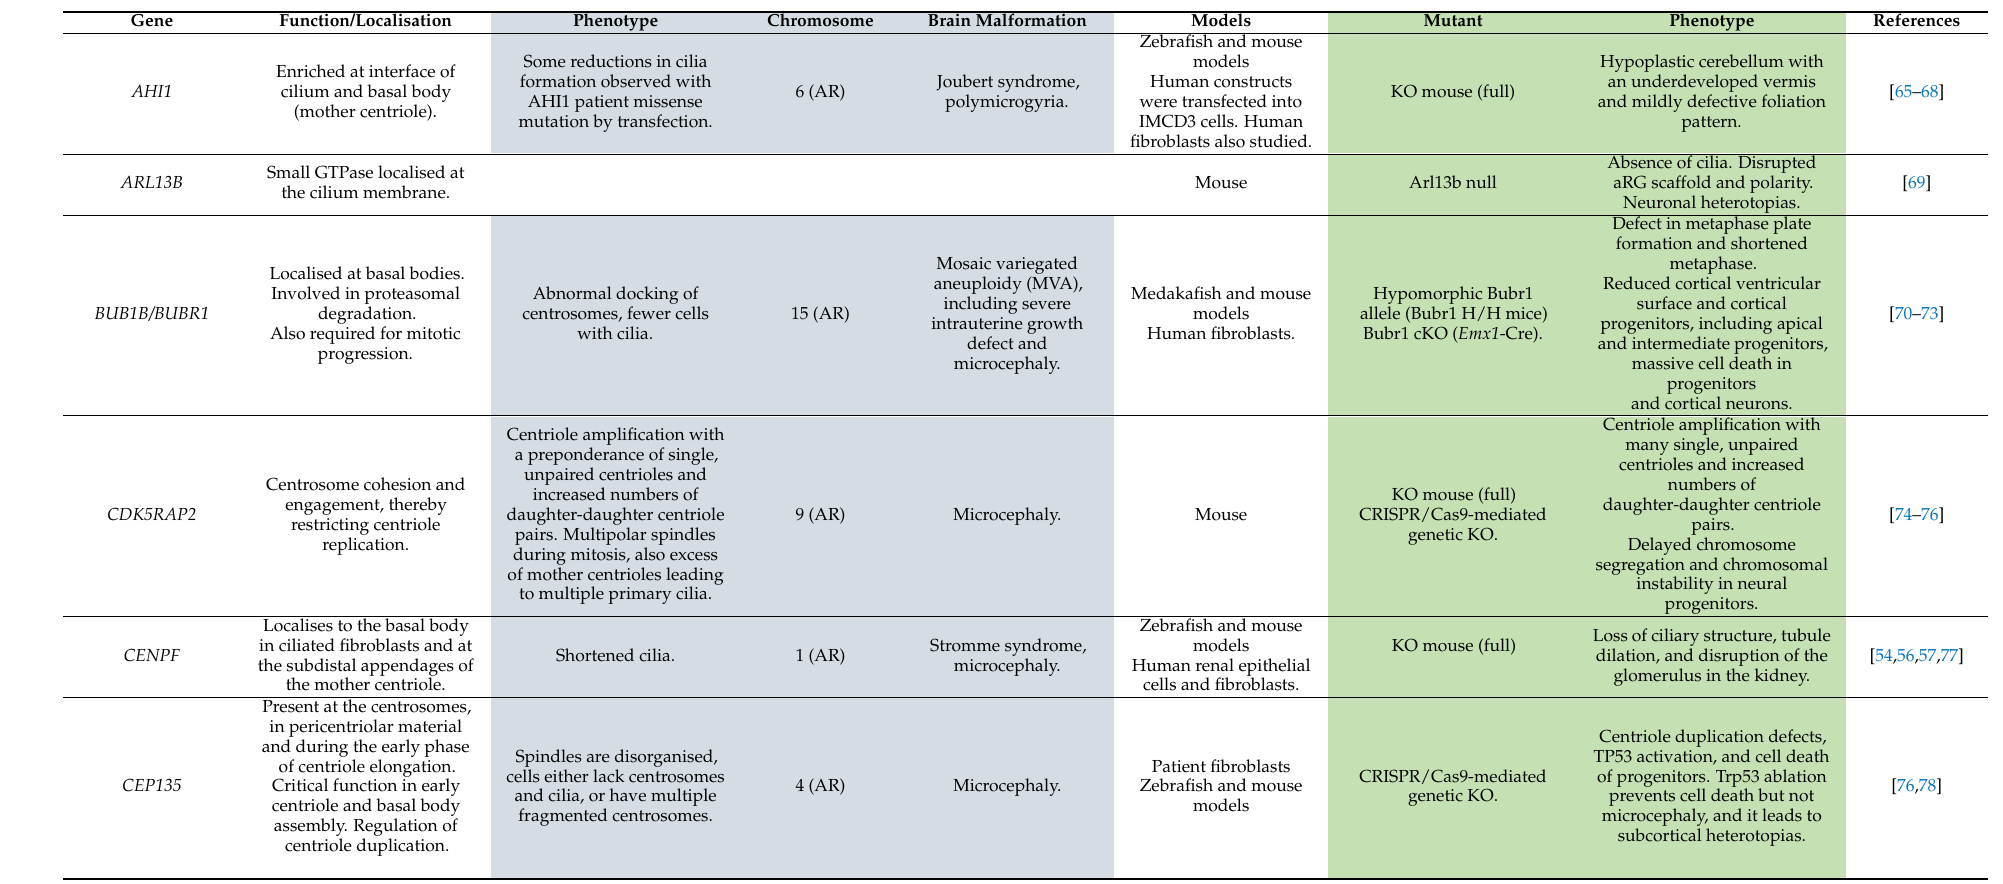
Table 1. Ciliary genes and proteins mutant in mouse and human in cortical malformations. Table representing a non-exhaustive list of genes involved in PC formation and function found mutated in human (blue-grey) and mouse (green). Genes are listed in alphabetic order. AR, autosomal recessive. AD, autosomal